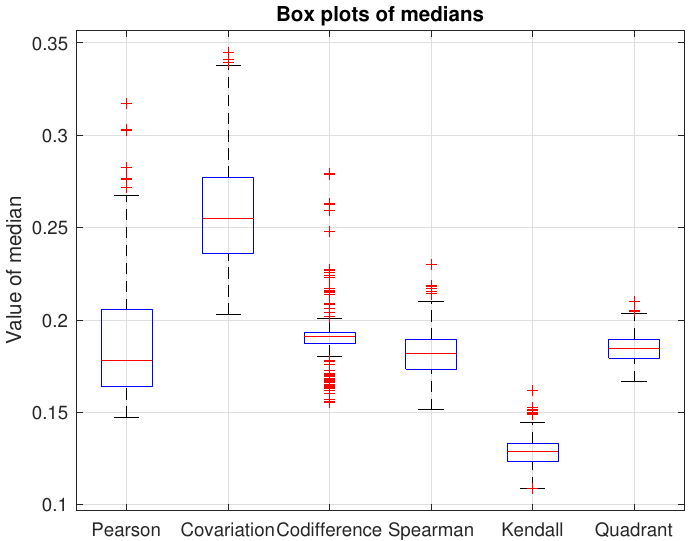
Figure 7. Boxplots of medians associated with heavy-tailed noise (part C of the frequency bands) of the considered auto-dependence maps based on the following measure of dependence: Pearson, Spearman, Kendall autocorrelation, autocovariation and autocodifference for the simulated signal s 1